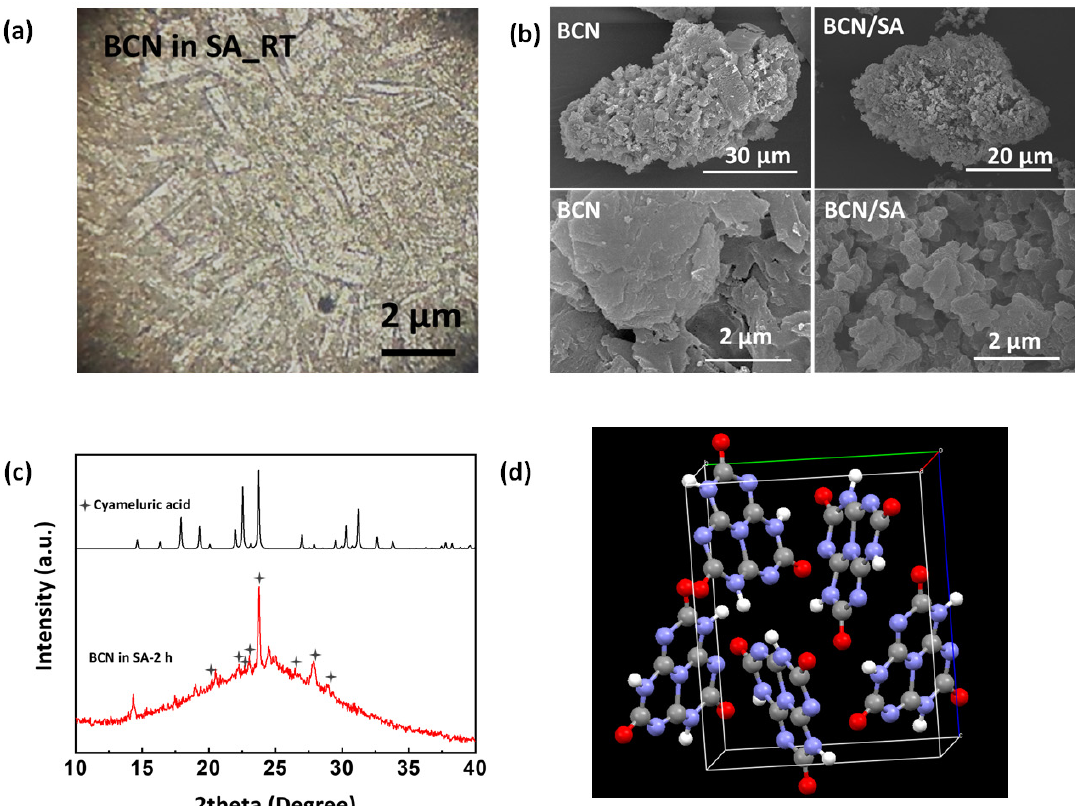
Figure 3. ( a ) The polarized optical microscopy (POM) image of BCN dissolved in SA for 2 h and then cooled to RT, ( b ) scanning electron microscopy (SEM) images of BCN and BCN/SA, ( c ) the X-ray diffraction (XRD) pattern of BCN dissolved in SA for 2 h and then cooled to RT, ( d ) pattern of cyameluric acid created using cif file with deposition number of 710,788 downloaded from the Cambridge crystallographic data center (CCDC). The crystal structure is created by Mercury 3.0 using the cif file.